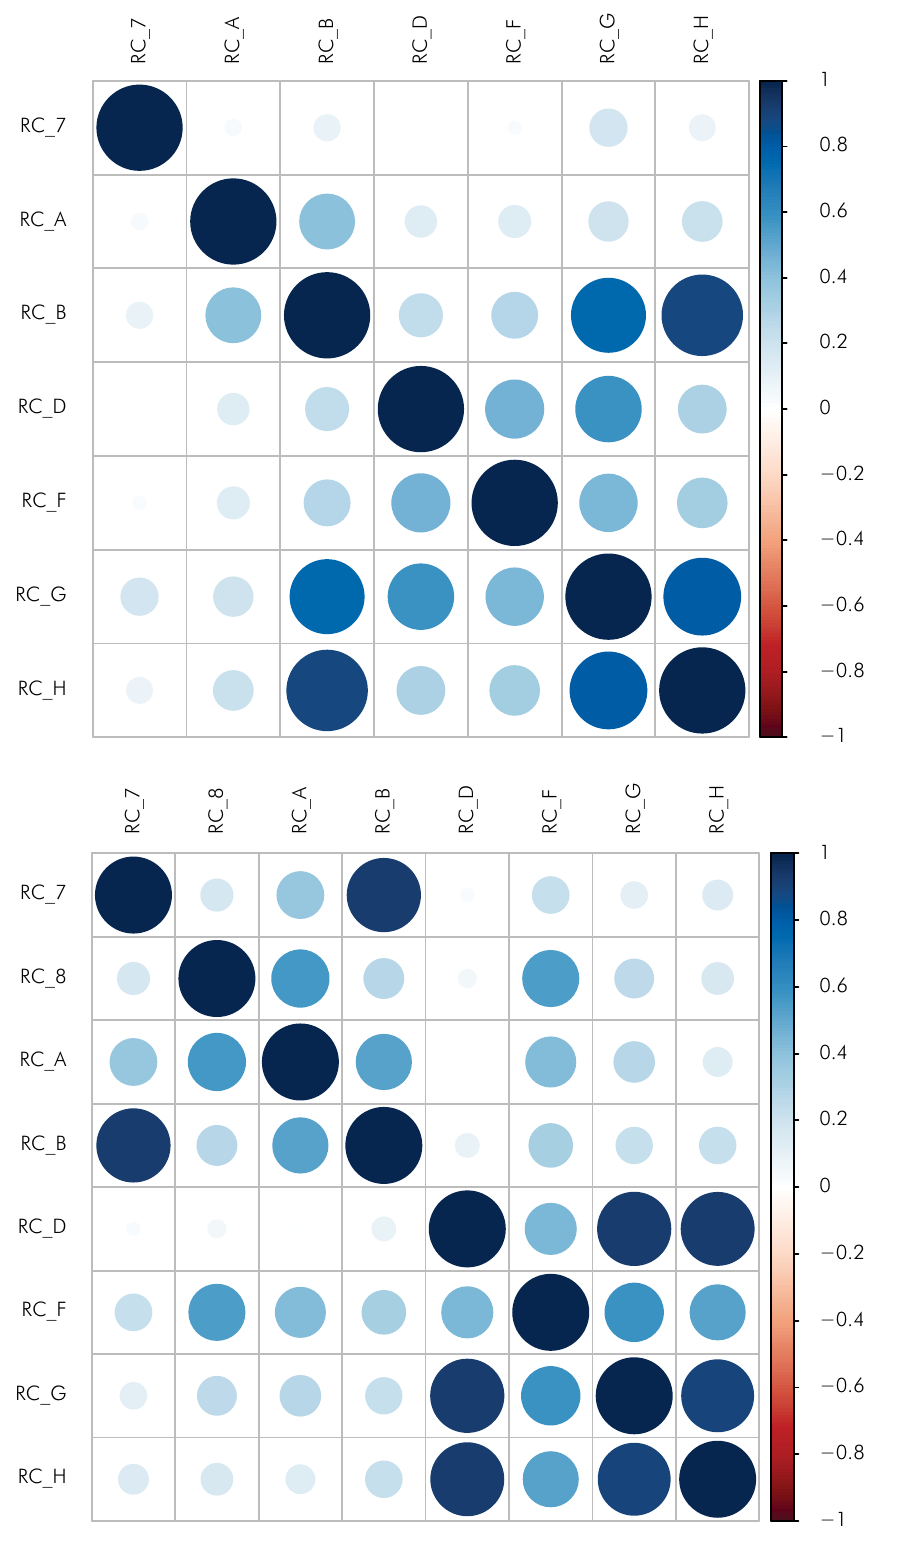
Figure 4. Degree of correlation analysis showing similarity of gene expression (number of reads) between all samples with putative presence of Scardovia spp. (A: S. inopinata ; n = 8; B: S. wiggsiae ; n = 7).